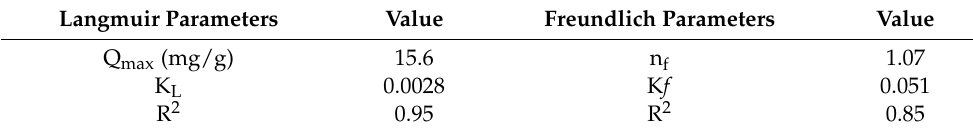
Table 2. Fitting parameters of adsorption isotherm models for MO adsorption on AS. Langmuir Parameters Value Freundlich